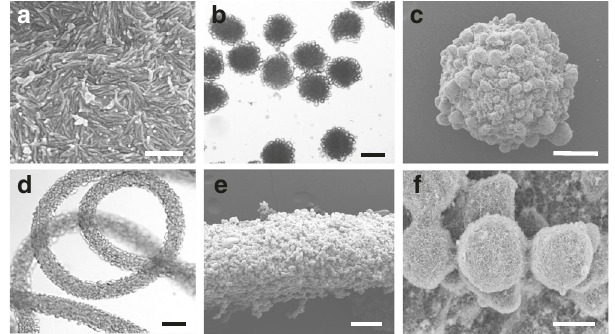
Fig. 4 Micro fl uidic fabrication of protein microparticles and micro fi bers with surface protrusions. a Scanning electron microscope (SEM) image of fi bril networks. Scale bar, 500 nm. b Optical microscope and c SEM images of microbeads with surface protrusions. d Optical microscope and e SEM images of a micro fi ber with f surface protrusions. Scale bars: 200 μ m ( b, d ), 100 μ m ( c , e ), and 10 μ m ( f